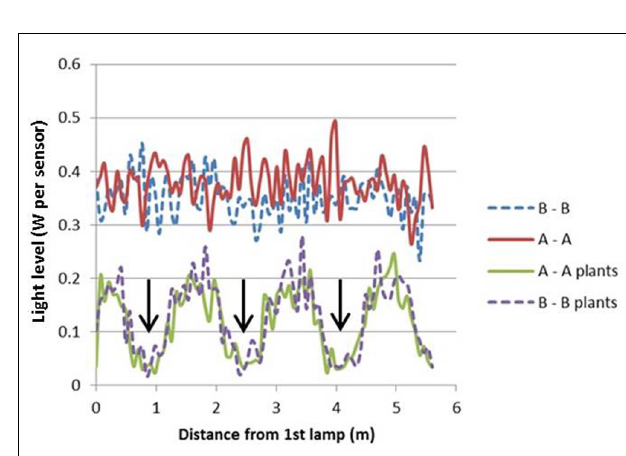
FIGURE 4 | Computed light intensity (W per sensor with 6 cm radius) at the trajectories of Figure 3, with and without light intercepting plants (plant positions indicated by arrows). For this simulation the HPS lamps had an arbitrary light output of 1000W m − 2 . Tilting the leaves upward decreased light interception of the downward light from sun and HPS lamps, but not for